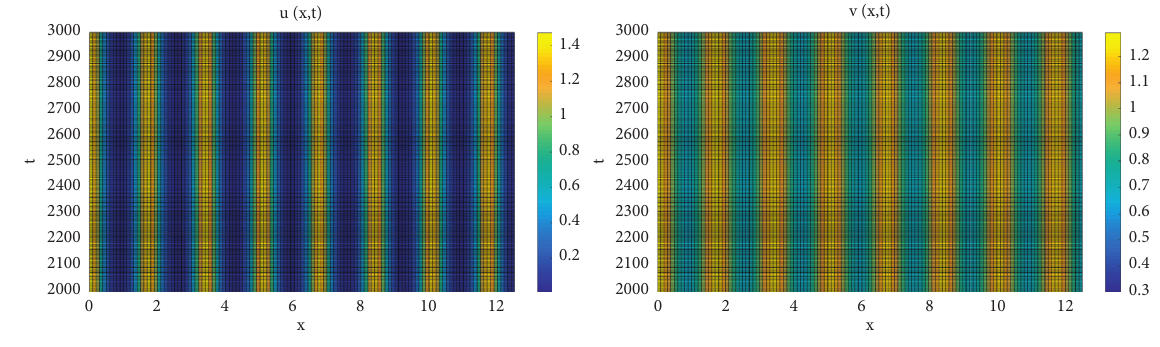
Figure 1: The numerical simulations of system (3) with τ �